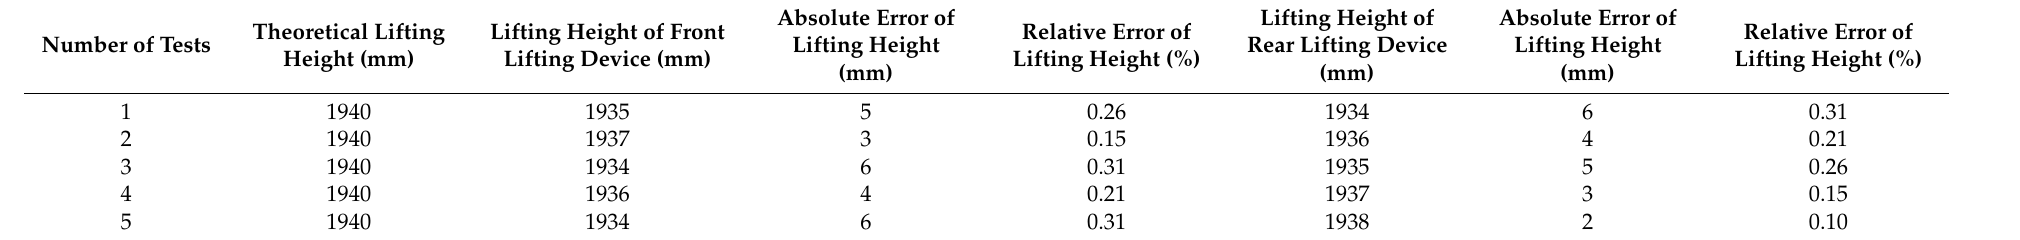
Table 12. Fruit-box-lifting device lifting height.